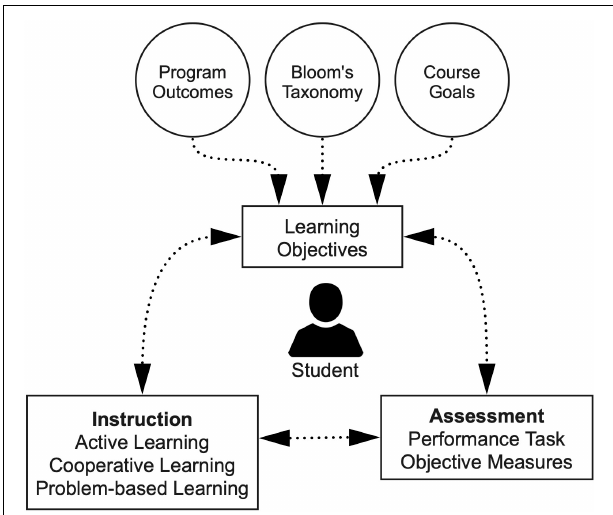
FIGURE 3 | Components of constructive alignment used to develop HydroLearn